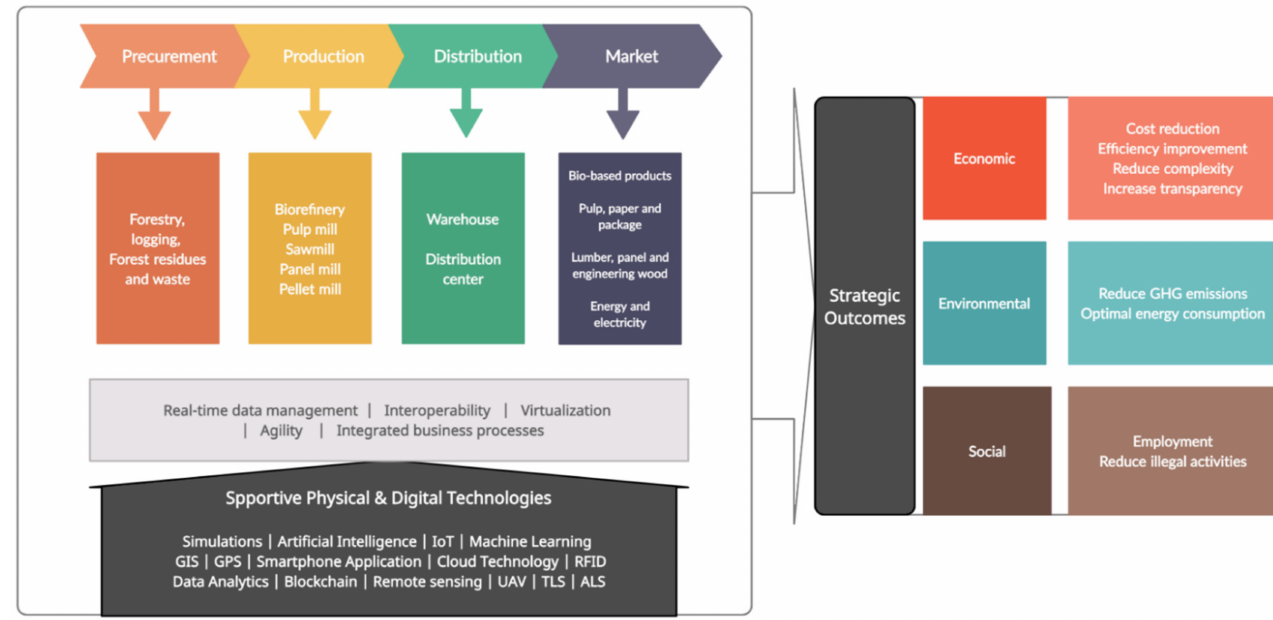
Figure 6. A framework of the forest supply chain in Industry